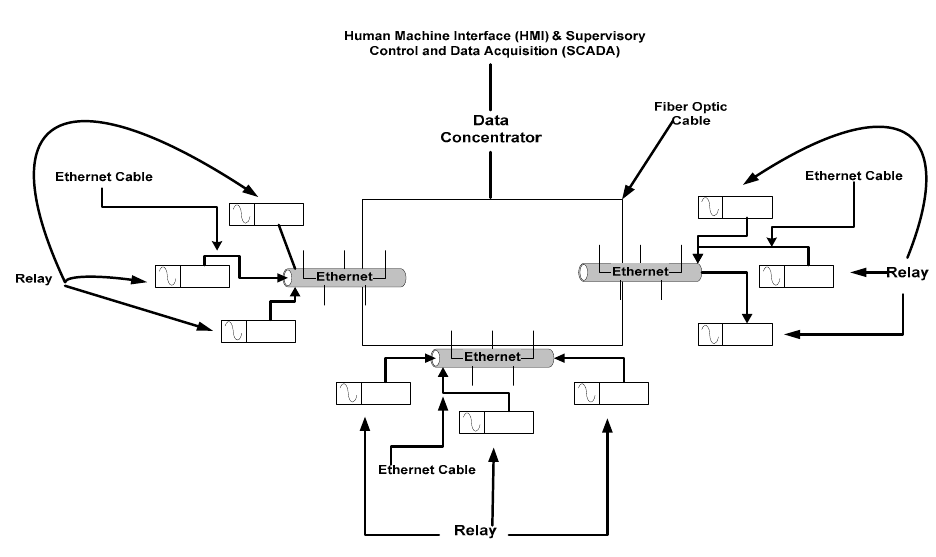
Figure 4. IEC 61850 typical architecture.